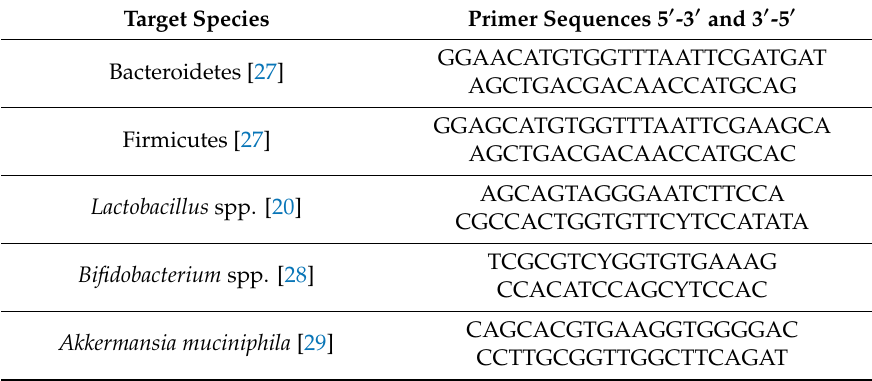
Table 1. Primers used for quantitative polymerase chain reaction (qPCR) quantification of species-specific 16S